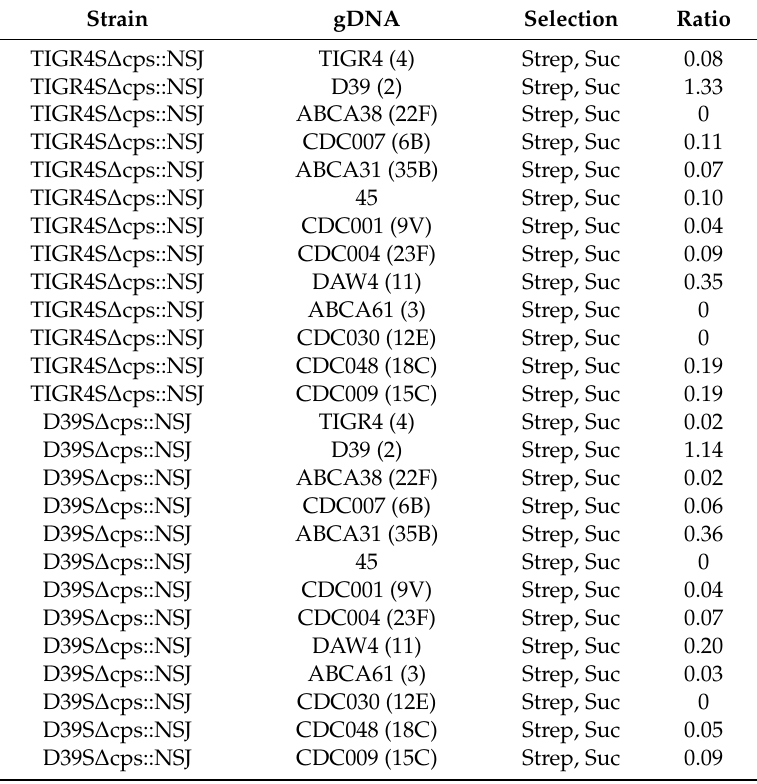
Table 7. Ratio of true positive to false positive colonies of TIGR4S ∆ cps::NewSweetJanus and D39S ∆ cps::NewSweetJanus transformed with genomic DNA of di ff erent serotypes. NSJ refers to NewSweetJanus. Selectionoccurredon800 µ g / mLstreptomycin(Strep), 10%sucrose(Suc), or7.5–15mM chlorinated-phenylalanine